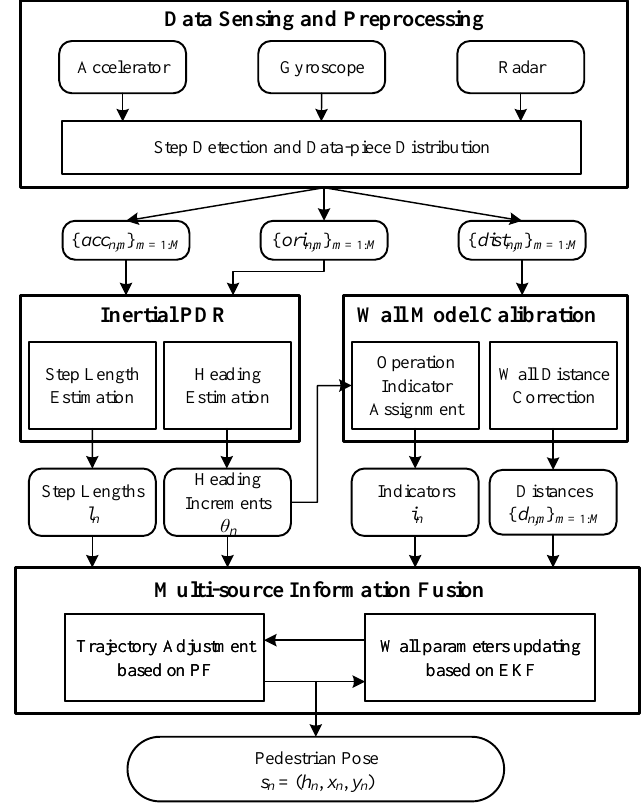
Figure 3. System